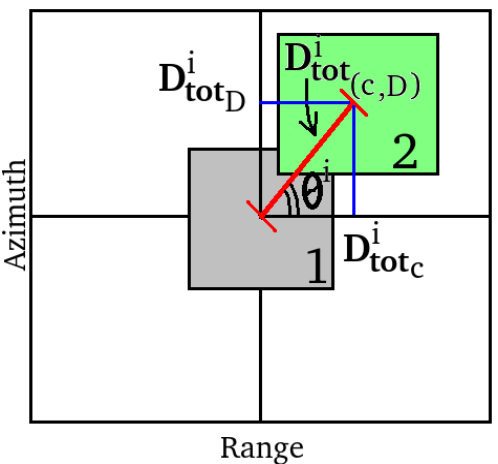
Figure 3. Schematic representation of isolated pixels with a certain shift due to space